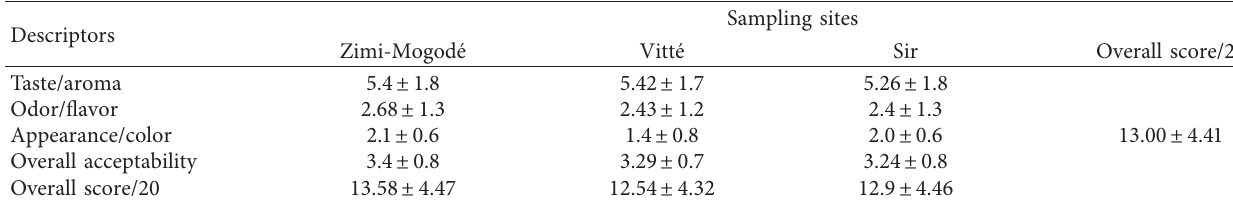
Table 7: Hedonic quality score of the yellow